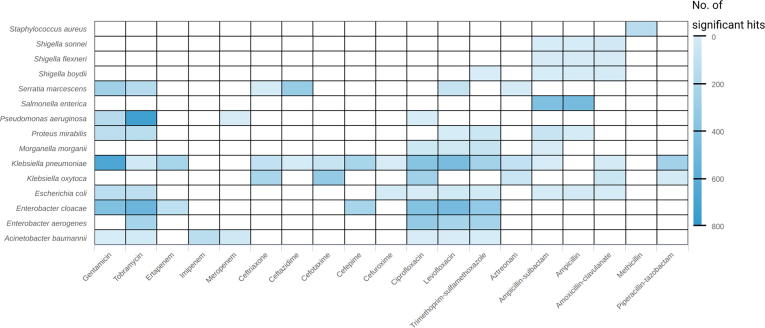
Number of significant results of the resistance association analysisSignificant results (adjusted P < 1E−5) of the resistance association analysis based on the presence/absence of centroids. The heatmap shows the number of significant results (in color gradient with lighter blue for smaller numbers and darker blue for larger numbers) per taxon and drug. Drugs are sorted according to their class.